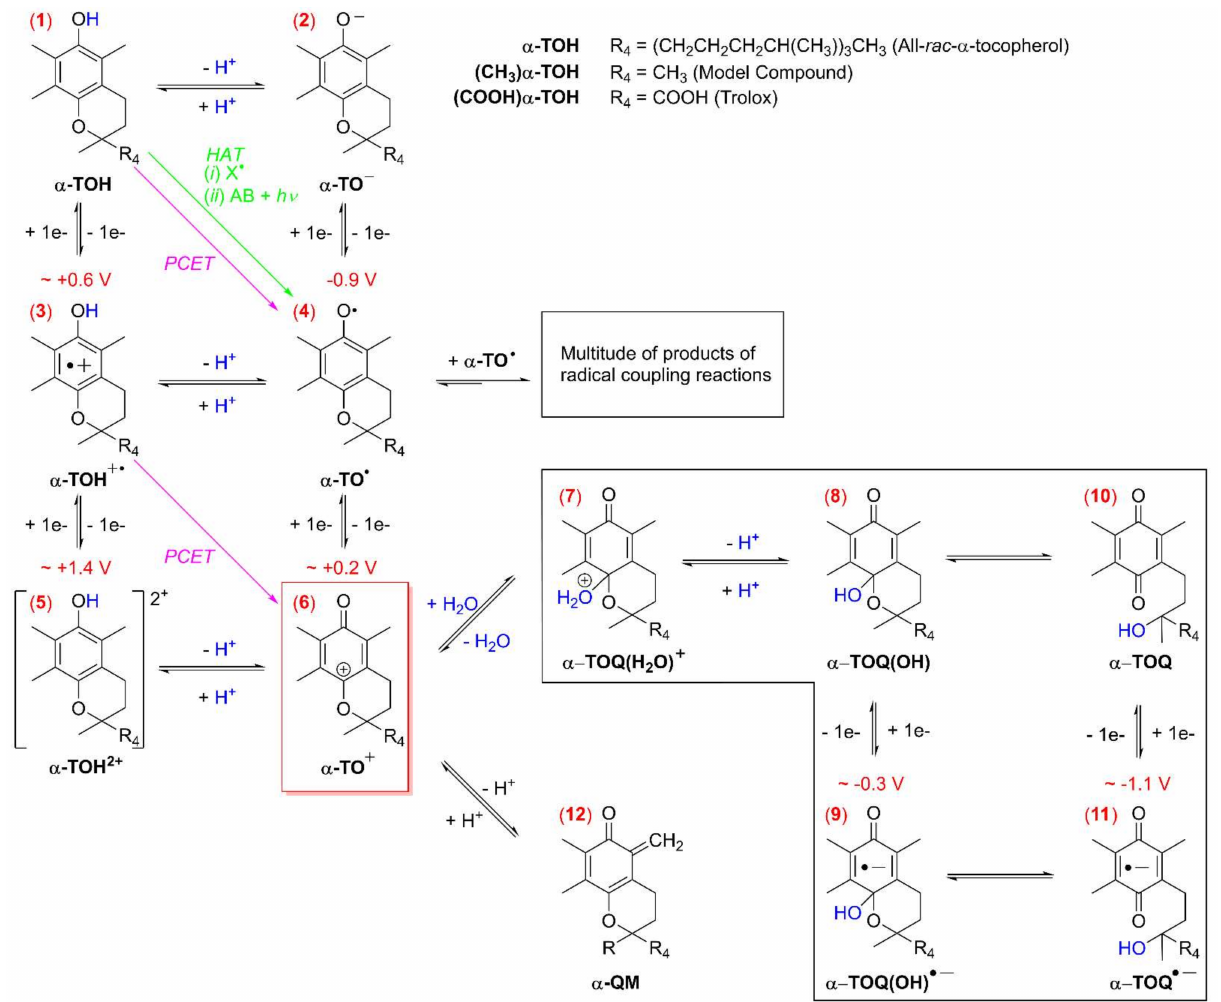
Scheme 2. Oxidation mechanism of α –tocopherol showing major intermediate forms and stable products. HAT = Hydrogen atom transfer. PCET = Proton–coupled electron